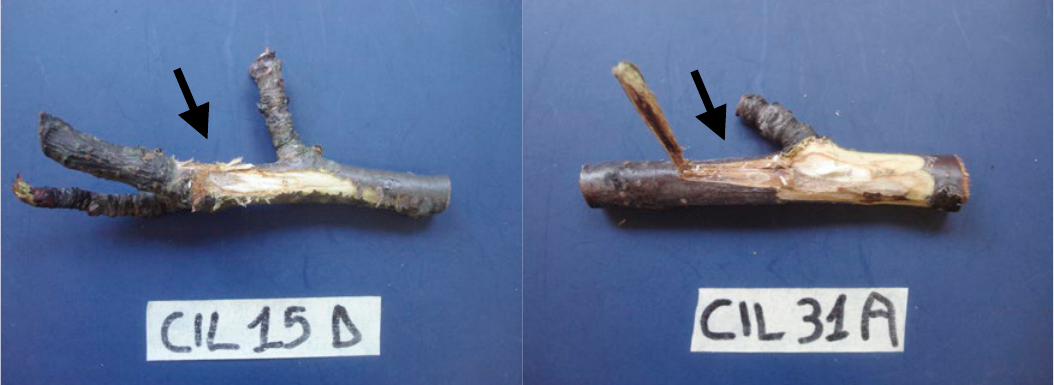
Figure 1. Branches of sweet cherry with portions of dark wood (arrow) infected by Leucostoma